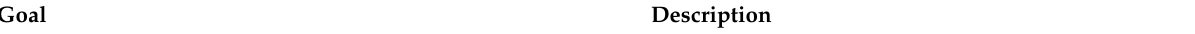
Table 1. Main goals of the IHD-EPITRAN study with brief respective descriptions. IHD , Ischemic heart disease.